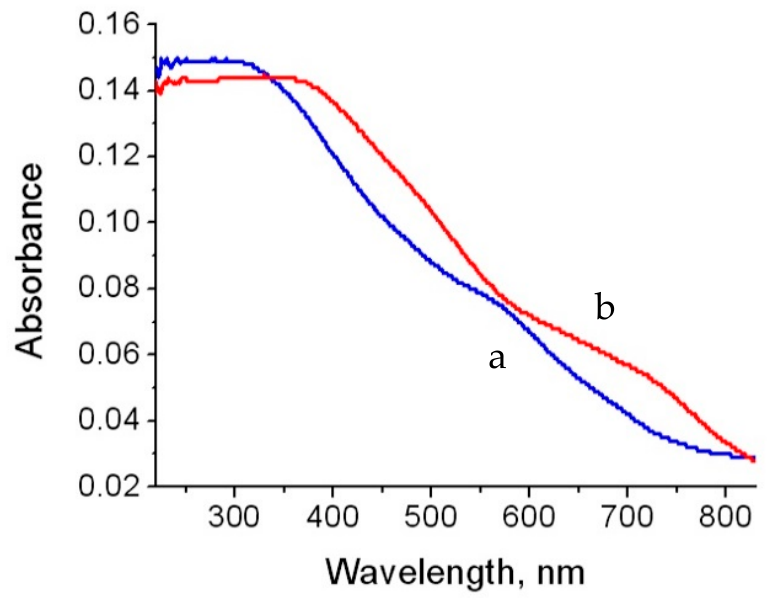
Figure 11. UV–Vis absorbance of: ( a ) BT2 and ( b ) BT1. The solar activity of BT1-600, BT2-600, BT2-900 and BT1-900 was tested through photocatalytic degradation of the green dyes (naphthol green B; NGB) from water in the presence of sunlight. At the same time, the commercial barium titanium oxide nanoparticles BaTiO 3 were used for comparison. The intensity of the absorption of naphthol green B at λ max = 720 nm has been used for expressing the concentration of the green pollutants. High stability of NGB in sunlight was observed because there were no changes in the absorption of the green dye. The mixture between the green dye and one of the solid materials was irradiated for ten minutes in sunlight. After that, the absorbance of the green solution was measured and used as the concentration for the green dyes. These results are revealed in Figures 13 and 14. In the presence of BT1-900 or BT2-900, the absorbance of NGB was strongly reduced after irradiation for 10 min in sunlight, as seen in Figure 13. Figure